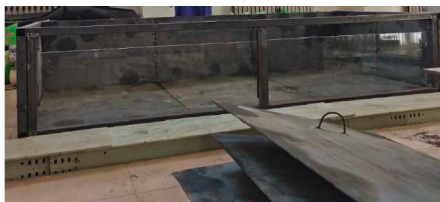
Figure 2: Model box.